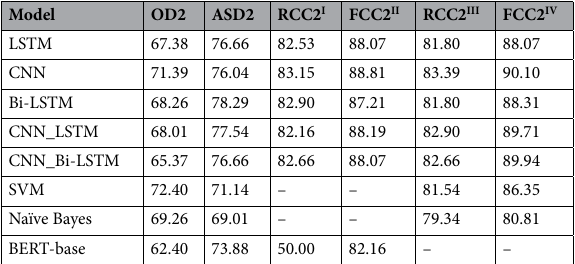
Table 8. The accuracy (%) achieved by the algorithms in document-level sentiment classification when trained with the OD2, ASD2, RCC2, and FCC2 datasets.